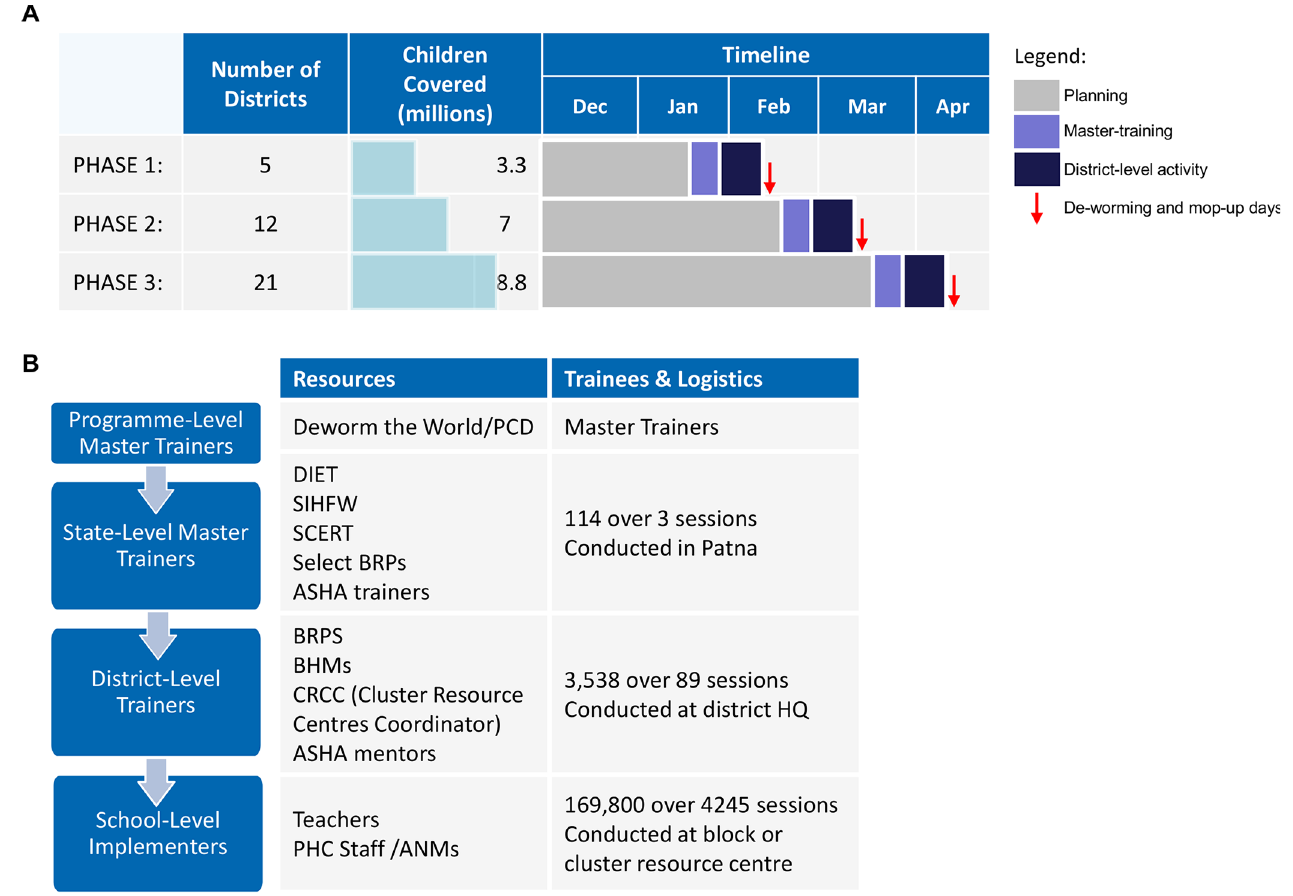
Fig 3. School-based deworming cascaded training and programme rollout in Bihar. A, The incremental three-phased approach, including numbers targeted in each phase. Timelines are shown, with indications of planning phases (light grey), training phases (light purple), and district-level activity (dark blue). Deworming days are indicated in red arrows. District-level activity includes school-level activities and the cascaded training of teachers and Primary Health Centre staff. B , Structure and design of cascaded training sessions from programme level to school level, including numbers trained and trainees. The cascaded system of training and dissemination of materials led to significant cost reductions and maximized use of available resources. Abbreviations: DtW/ PCD, Deworm the World and the Partnership for Child Development; DIET, District Institute of Education and Training; SIHFW, State Institute of Health and Family Welfare; SCERT, State Council of Education Research and Training; CRP, Cluster Resource Persons; ASHA, Accredited Social Health Activist; BRP, Block Resource Persons; BHM, block health managers; CRCC, Cluster Resource Centres Coordinator; PHC, Primary Health Centre; ANM, Auxiliary Nurse Midwife; HQ,